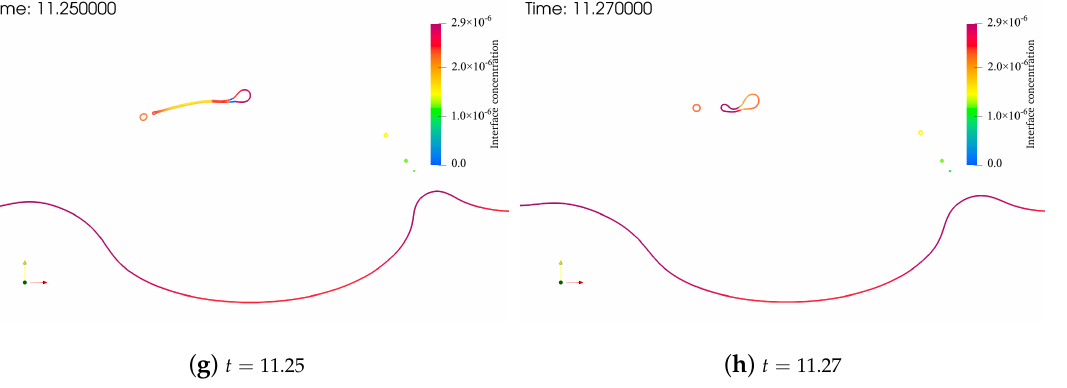
Figure 18. Interface concentration profile focused on the liquid film area during the liquid film rupture process in surfactant solution with a Langmuir number of La = 15, from t = 11.13 to t = 11.27, with an interval of ∆ t = 0.02. The color legend ranges from f = 0 to a saturation concentration of f = 2.9 × 10 − 6